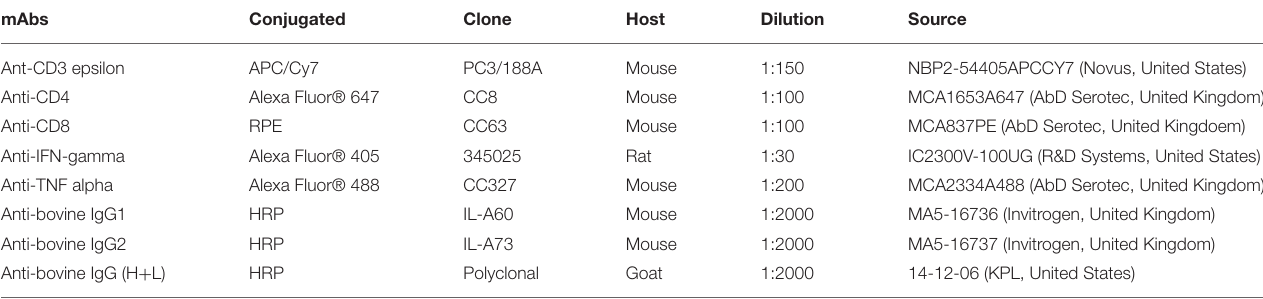
TABLE 2 | Monoclonal and polyclonal antibodies (mAbs) used in this study for flow cytometry analysis and immunological assay.